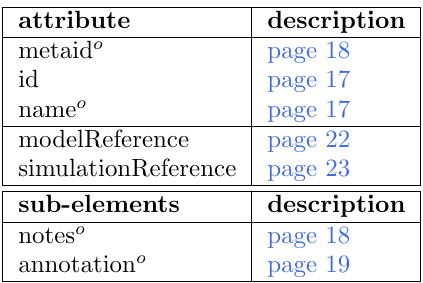
Table 2.21: Attributes and nested elements for task. xy o denotes optional elements and